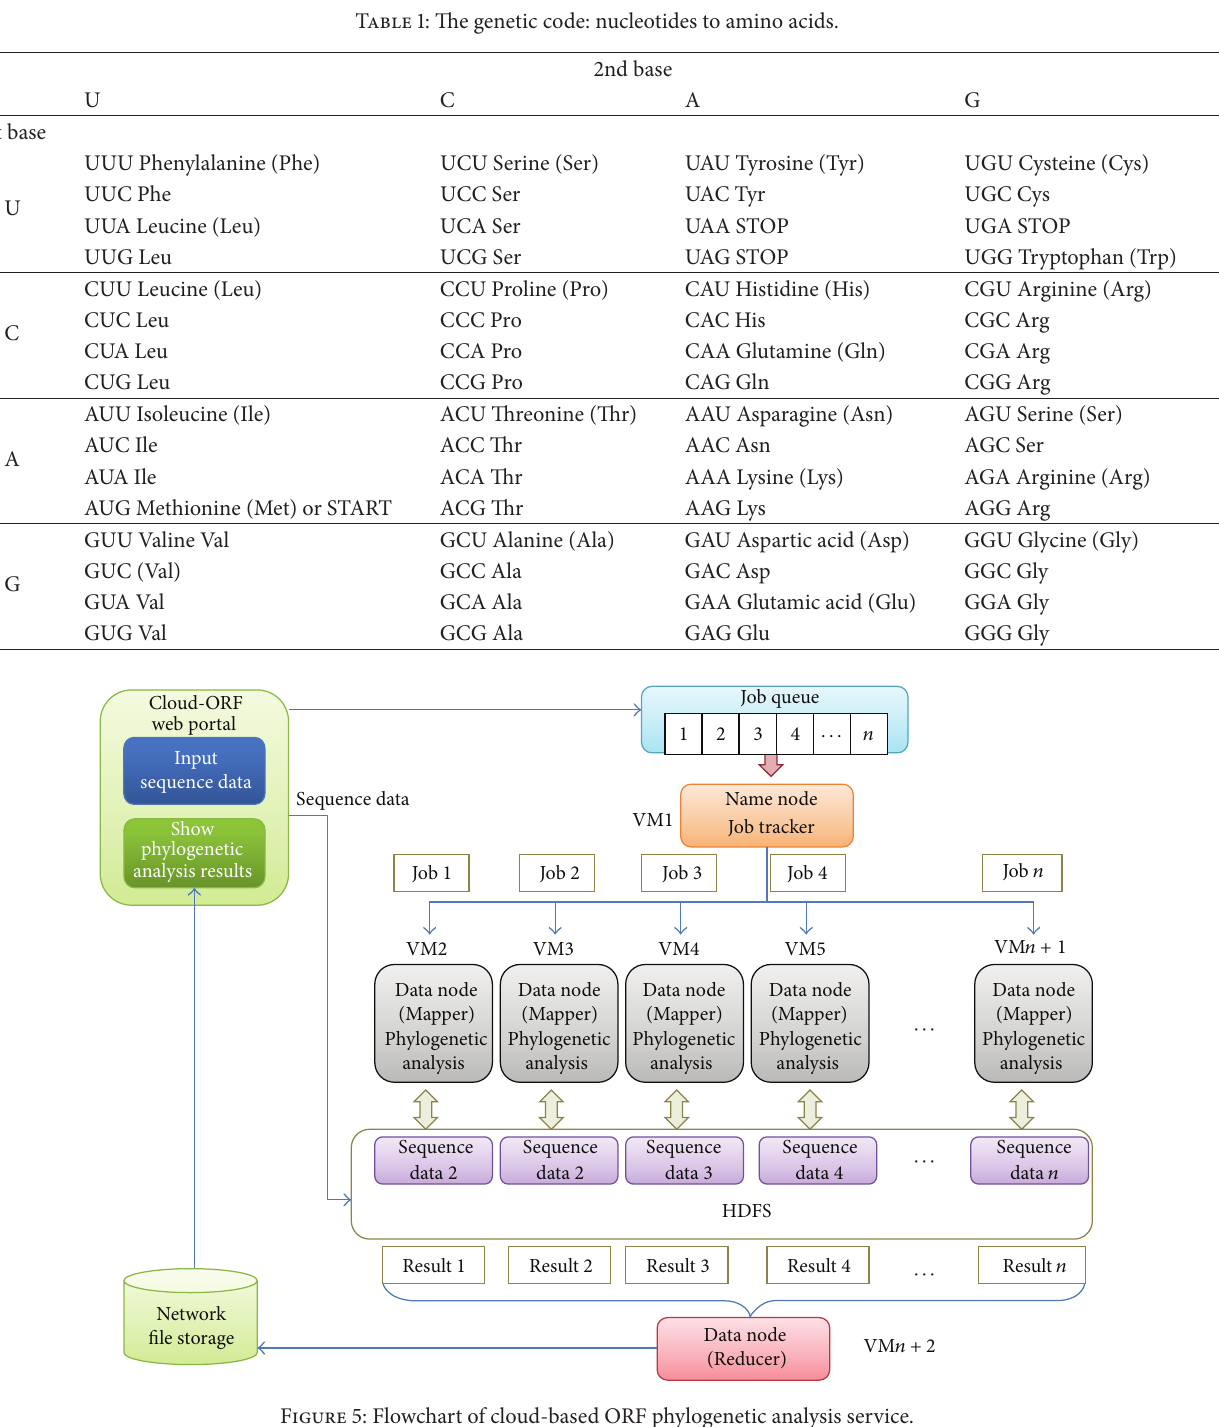
Figure 5: Flowchart of cloud-based ORF phylogenetic analysis